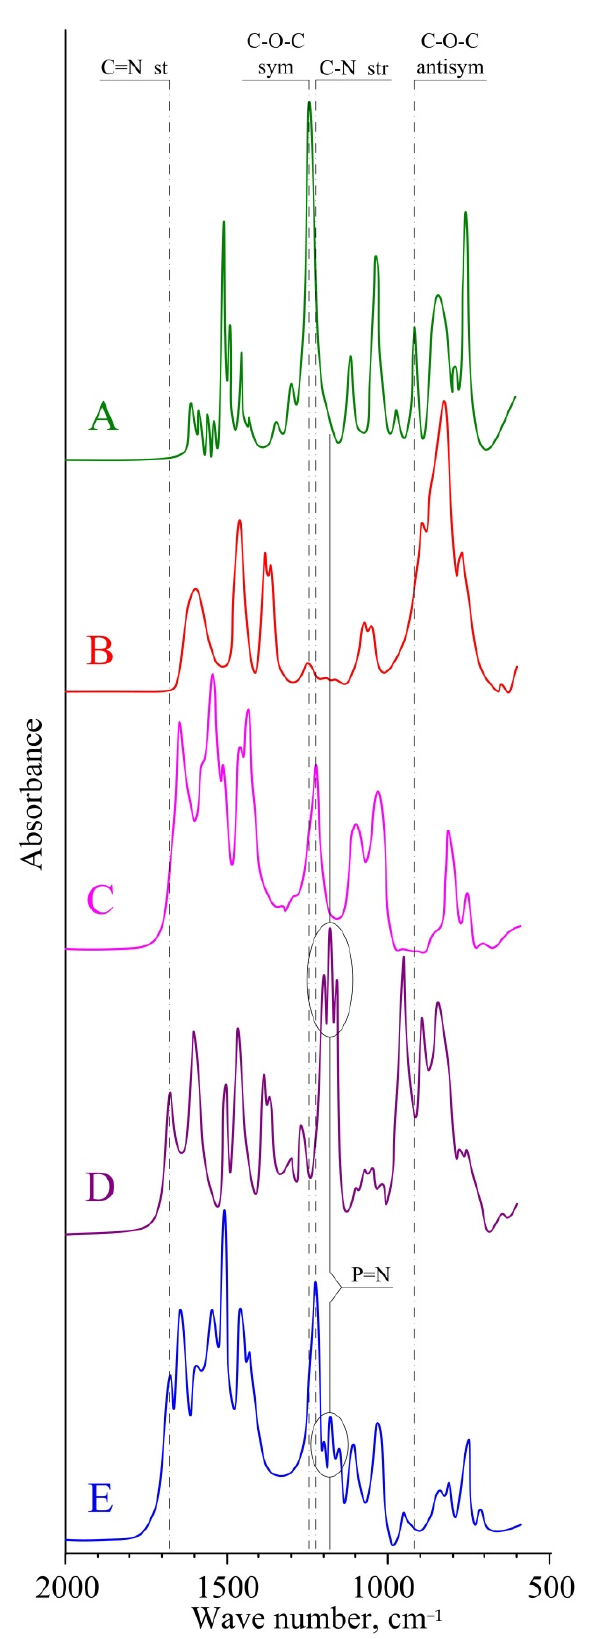
Figure 5. IR spectra: DER-354 ( A ); IPDA ( B ); DER-354 cured with pure IPDA ( C ); IPDA containing 30 wt.% FPP ( D ); DER-354 cured with IPDA containing 30 wt.% FPP ( E ). The presence of the phosphazene modifier in the hardener affected the glass transi- tion temperature of the studied compositions. As can be seen from Table 4, the Tg of the compositions cured with IPDA containing up to 20% modifier was slightly higher than that of compositions cured with pure IPDA. However, with 30% phosphazene in the